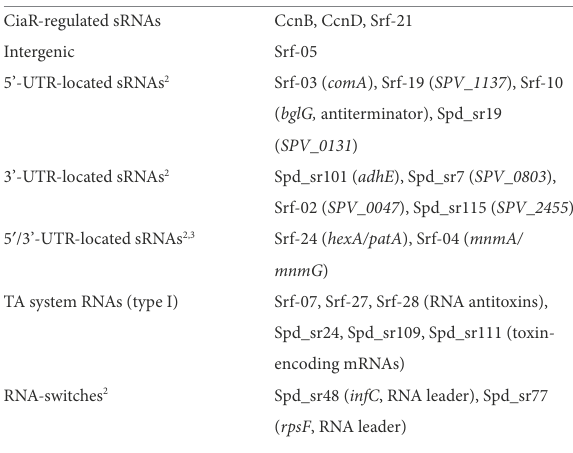
1 Based on previous studies, or predicted from available data [PneumoBrowse, or Sinha, Dhriti et al. (Sinha et al., 2019)]. 2 Associated genes in parenthesis. 3 sRNAs with a shared predicted promoter with the downstream gene and shared predicted transcriptional terminator with upstream